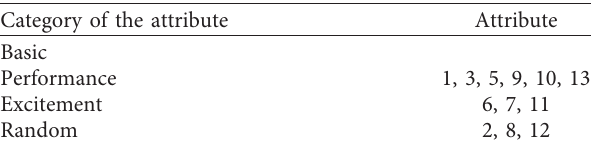
Table 14: Categories of the attributes based on the rules presented in Section 3 for the customer having the average customer satis- faction